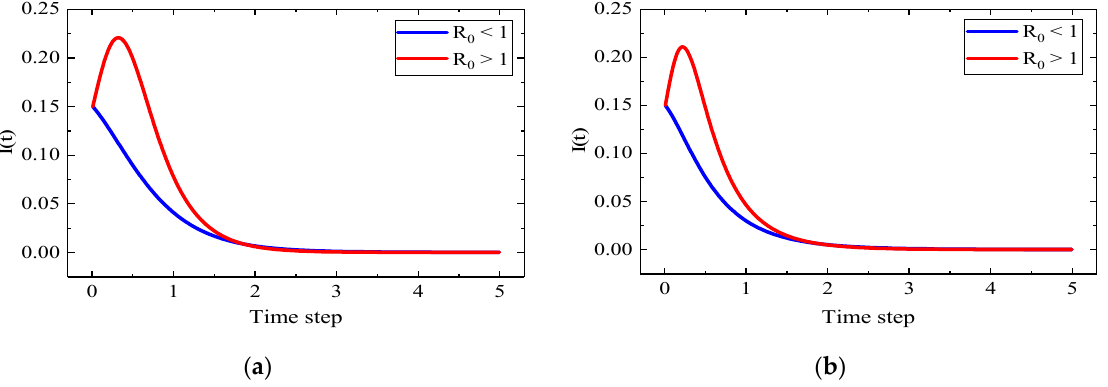
Figure 4. The changes of spreaders in ( a ) WS network and ( b ) BA network over time when R 0 < 1 and R 0 > 1.